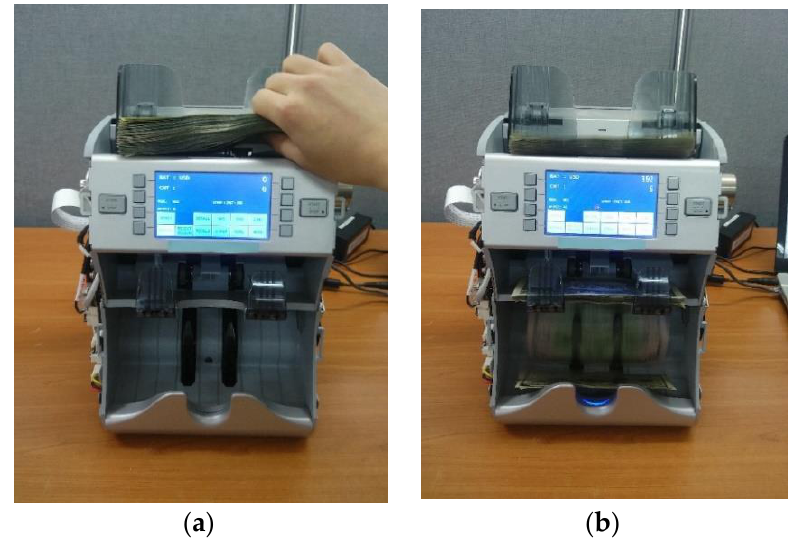
Figure 3. Example of capturing images of banknotes: ( a ) Inserting banknotes; ( b ) Banknote image capture.